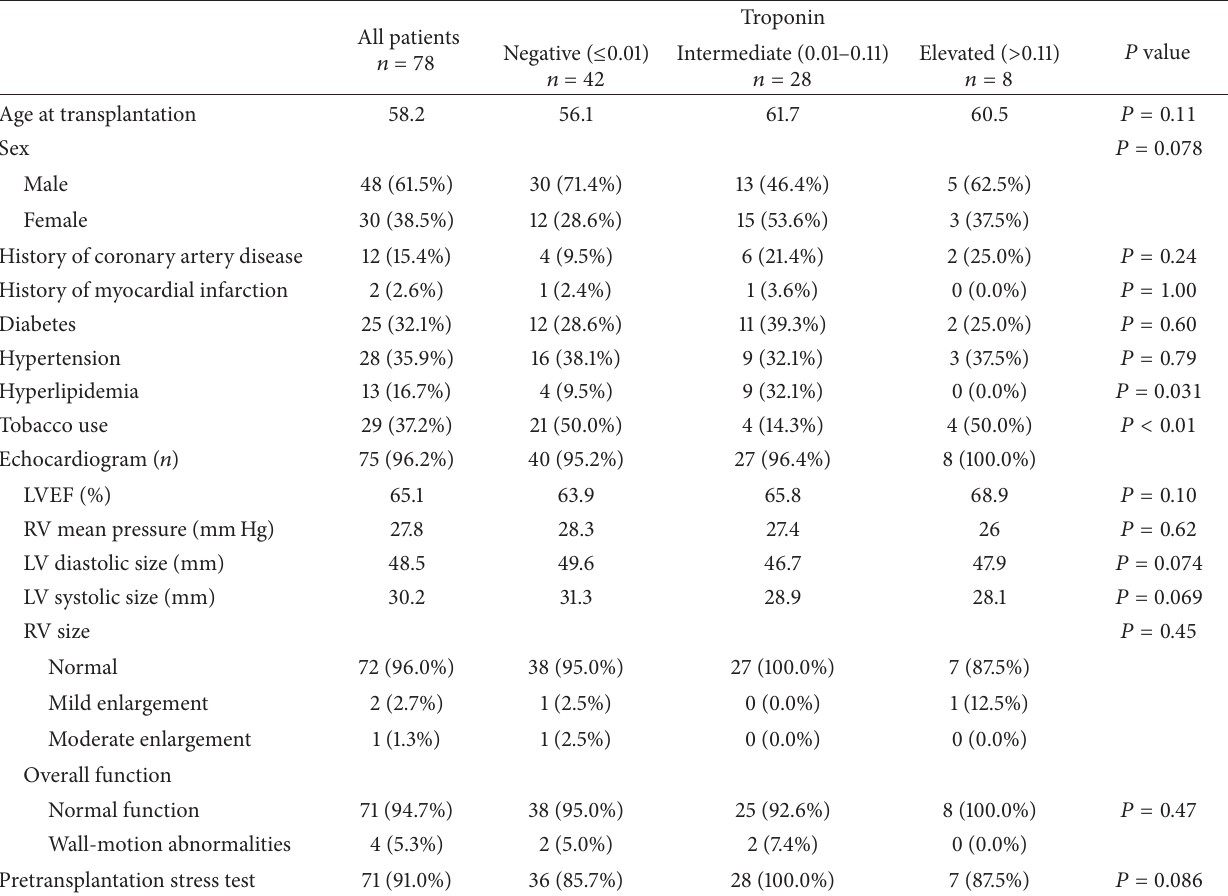
Table 1: Baseline patient characteristics prior to